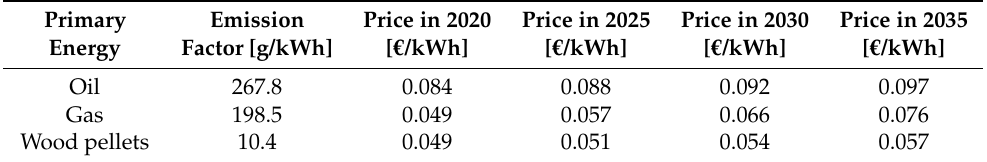
Table 3. Emission factors and primary Energy Prices for each optimization year.